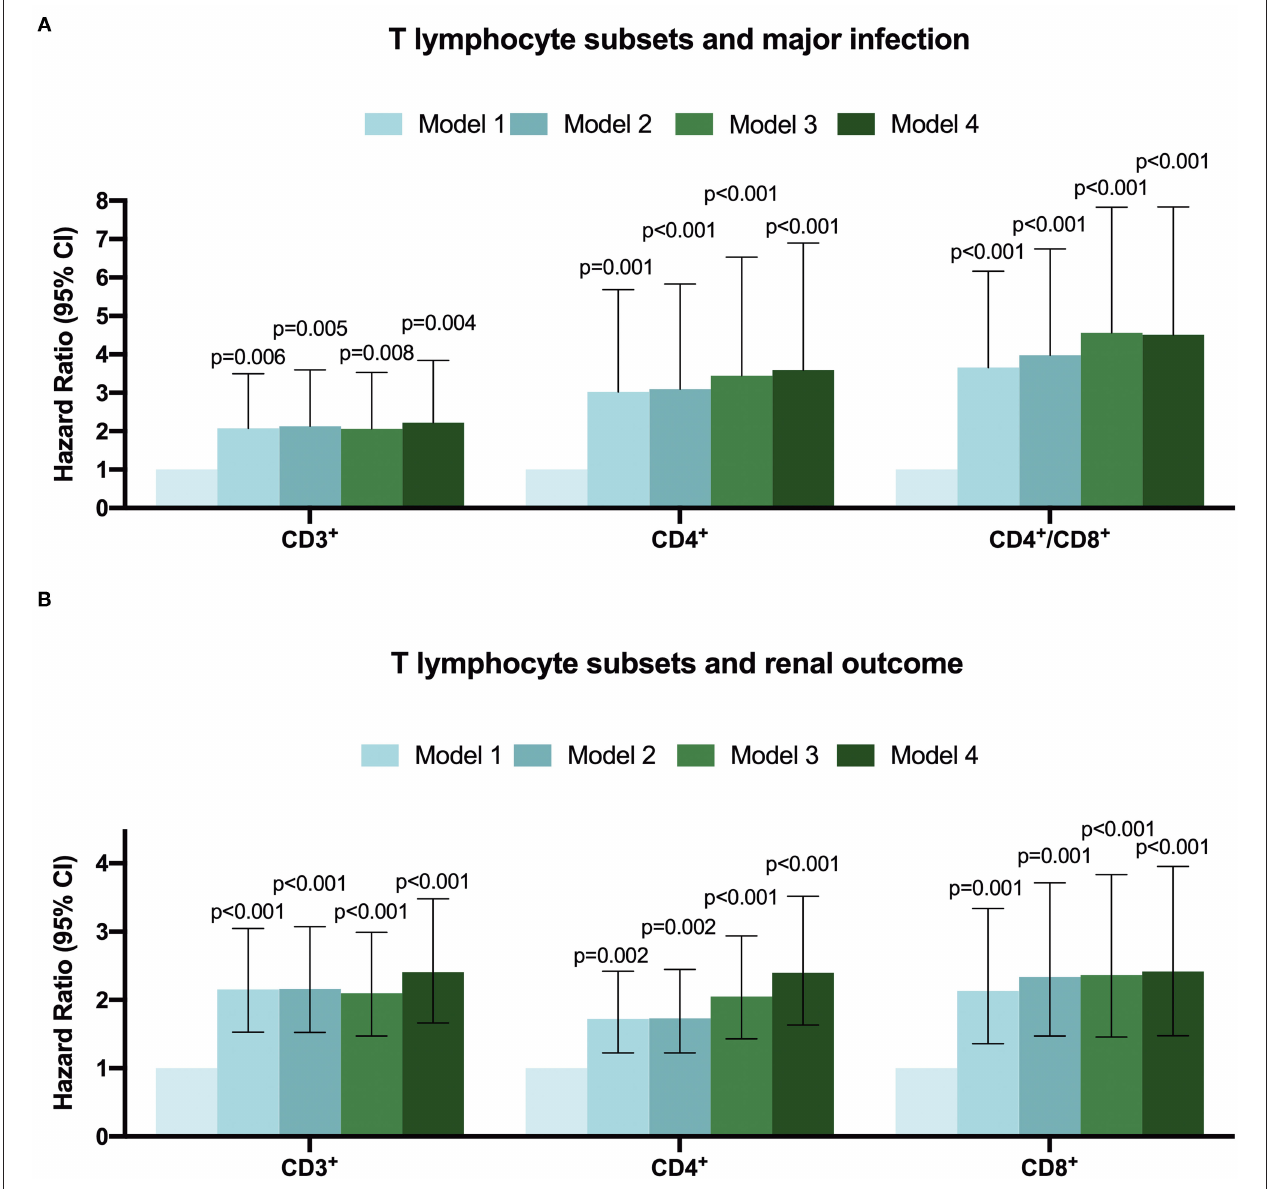
FIGURE 3 | The Hazard ratio for T-lymphocyte subsets with major infection (A) renal outcome (B) in CKD patients by multivariate-adjusted models.